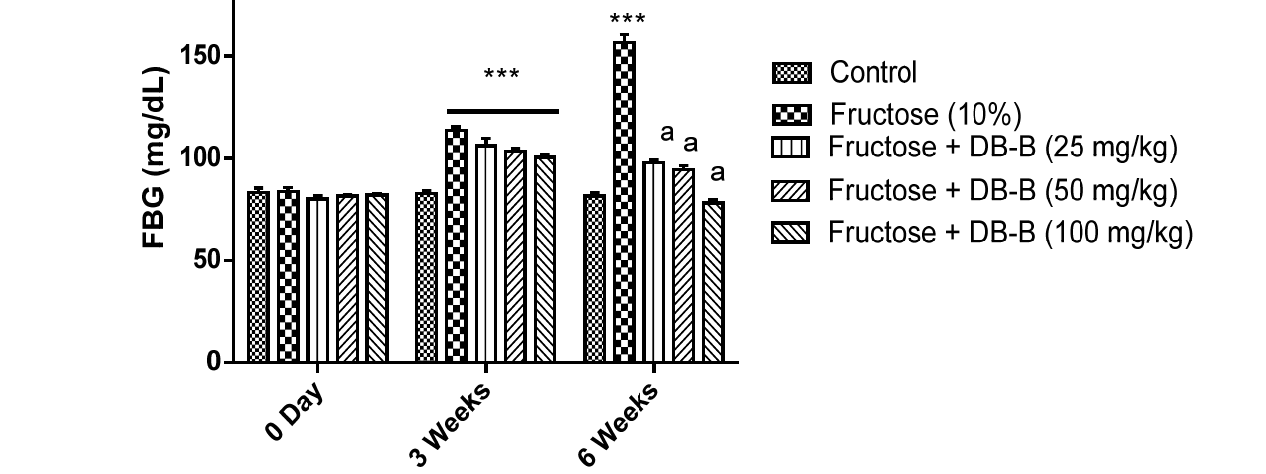
Figure 5. D. brunonianum reversed the fructose-induced rise in the level of blood glucose. Each bar is presented as mean ± SEM of five values where *** = p < 0.001 as compared with the control, while a = p < 0.001, in comparison with the results of the fructose (10%) group.